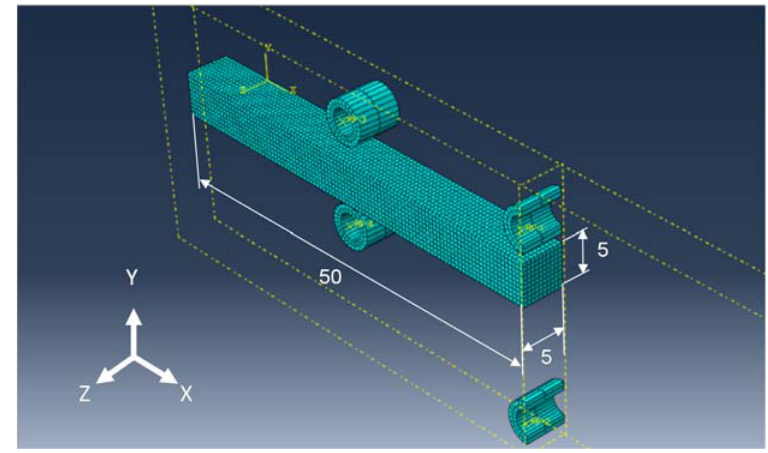
Figure 4. Quarter symmetry design.